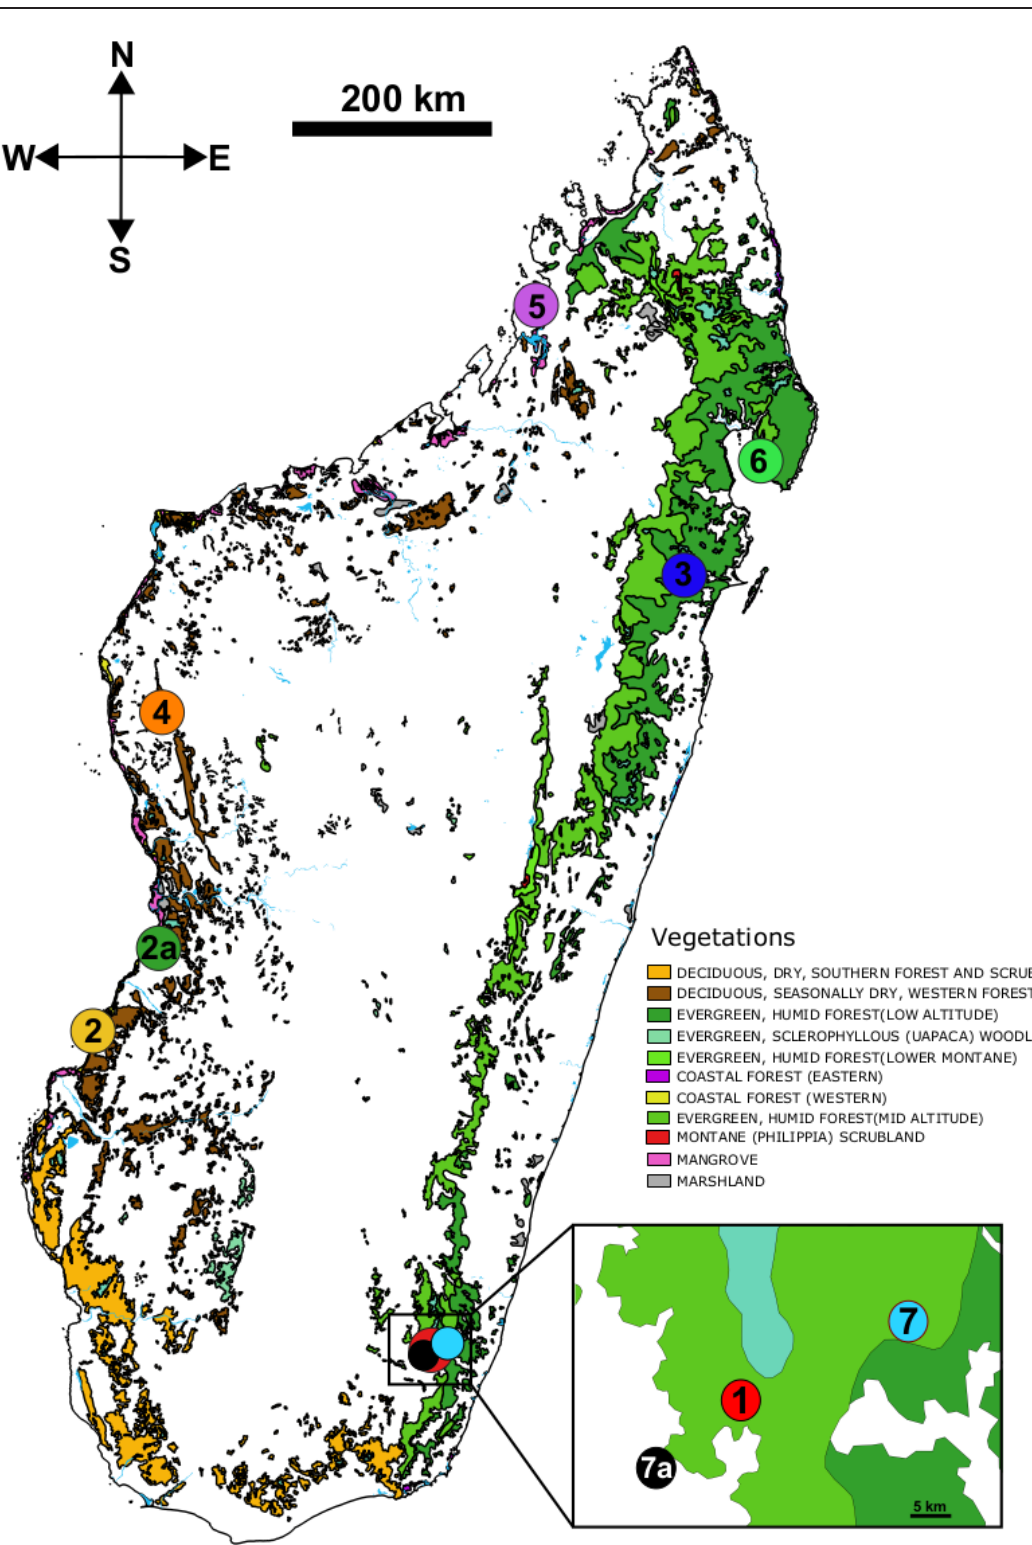
Fig. 3. Distribution map of the newly described species of Zoosphaerium . Vegetation color marks modified from Moat & Smith 2007. 1 = Z. nigrum sp. nov.; 2 = Z. silens sp. nov.; 3 = Z. ambatovaky sp. nov.; 4 = Z. beanka sp. nov.; 5 = Z. voahangy sp. nov.; 6 = Z. masoala sp. nov.; 7 = Z. spinopiligerum sp. nov. Numbers followed by ‘a’ mark additional, non-type